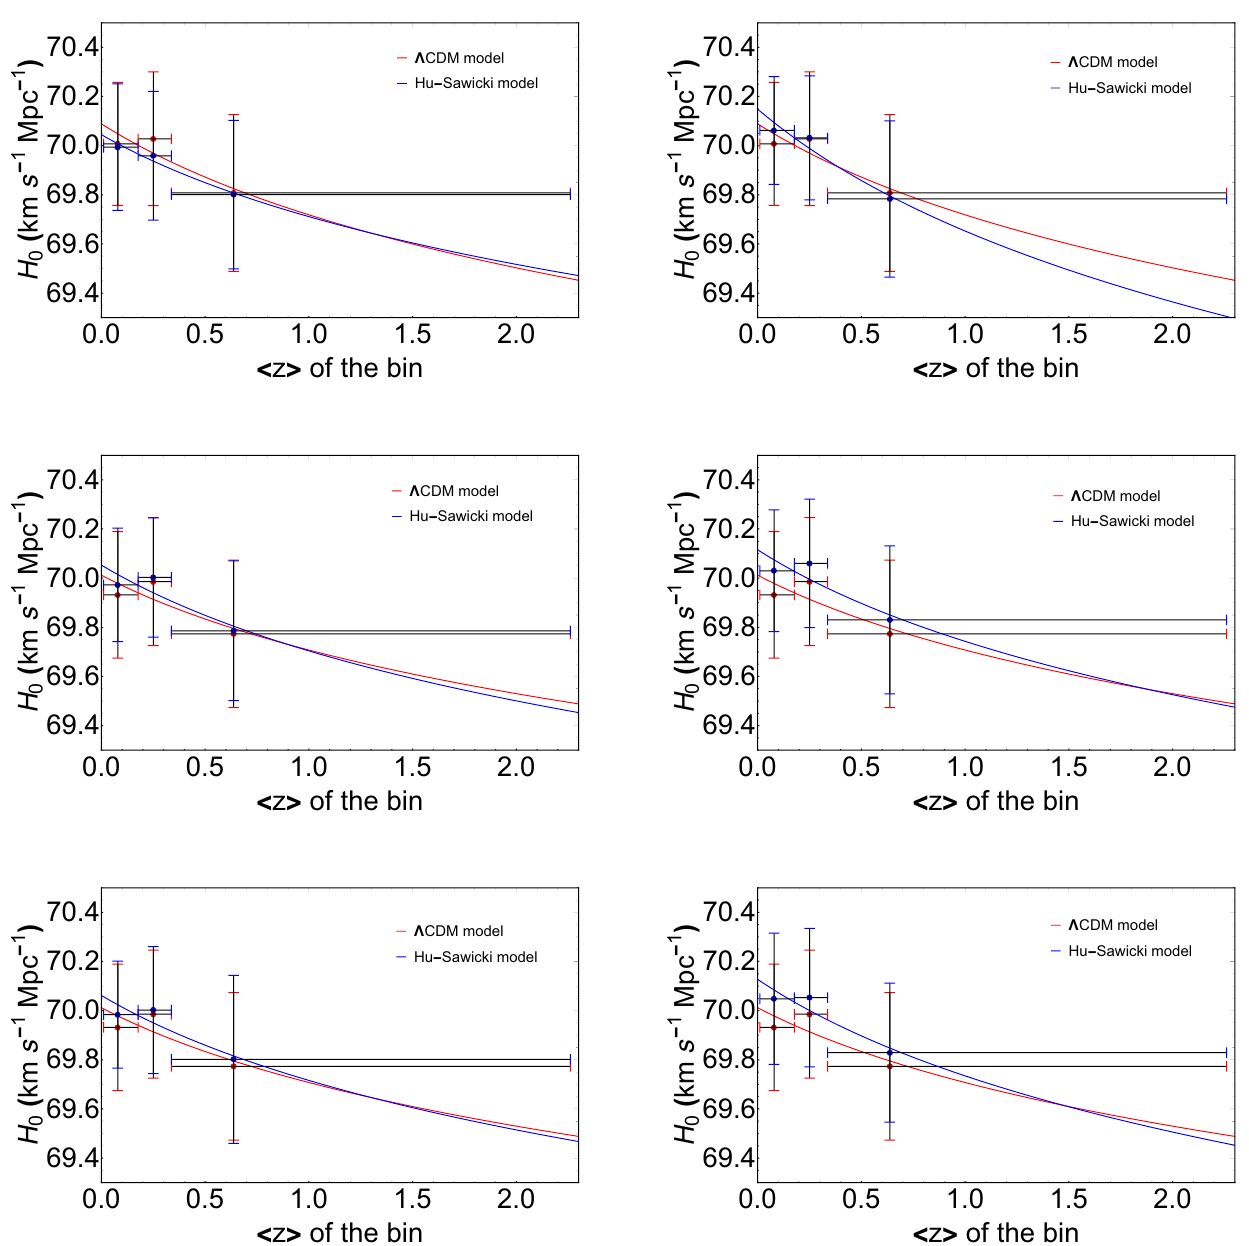
Figure 5. The first four panels deal with H 0 vs. z for SNe, the four bottom panels include BAO measurements for the H-S model. The upper 4 panels show from the left to the right red and the Hu–Sawicki model in blue. Analogously, the bottom panels have the same notation about the values of F R 0